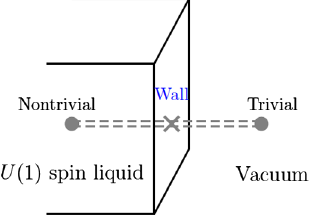
FIG. 5. The “ wall ” between a U ð 1 Þ spin liquid and a Higgsed vacuum. A particle ( E or M ) tunnels through the wall and becomes a trivial boson, which subsequently condenses and forms the vacuum. Some nontrivial excitation must be left behind on the wall after the tunneling